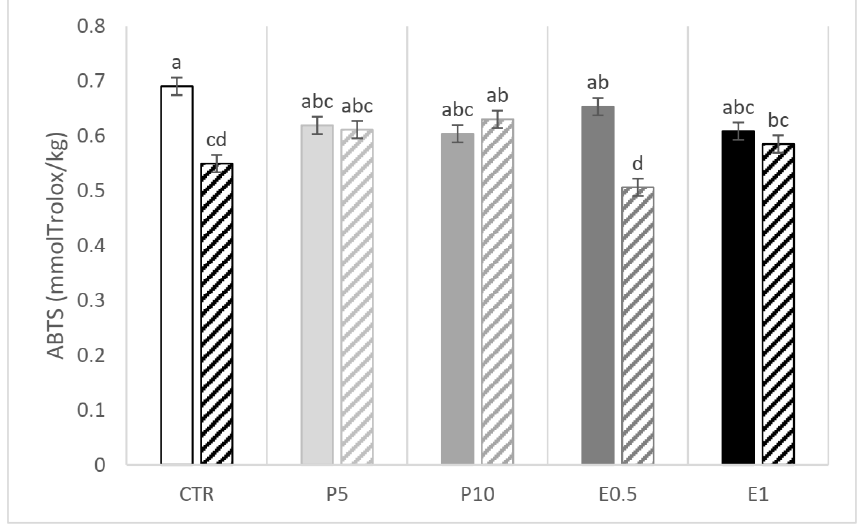
Figure 2. ABTS values (mmol eq. Trolox/kg fillet) of fillets from fish fed the CTR: control diet without HBP and HBP_SFE (white bars); P5 (light grey bars) and P10 (grey bars): diets including 5% or 10% of honeybee pollen (HBP), respectively; E0.5 (dark grey bars) and E1 (dark bars): diets including 0.5% or 1% of supercritical fluid extract (SFE) of HBP (HBP_SFE), respectively. Full colored bars are for samples analyzed at day 0, while crossed bars are for samples analyzed at day 110. The letters a, b, c, d indicate statistically different means according to the significant T × S interaction ( p < 0.05).